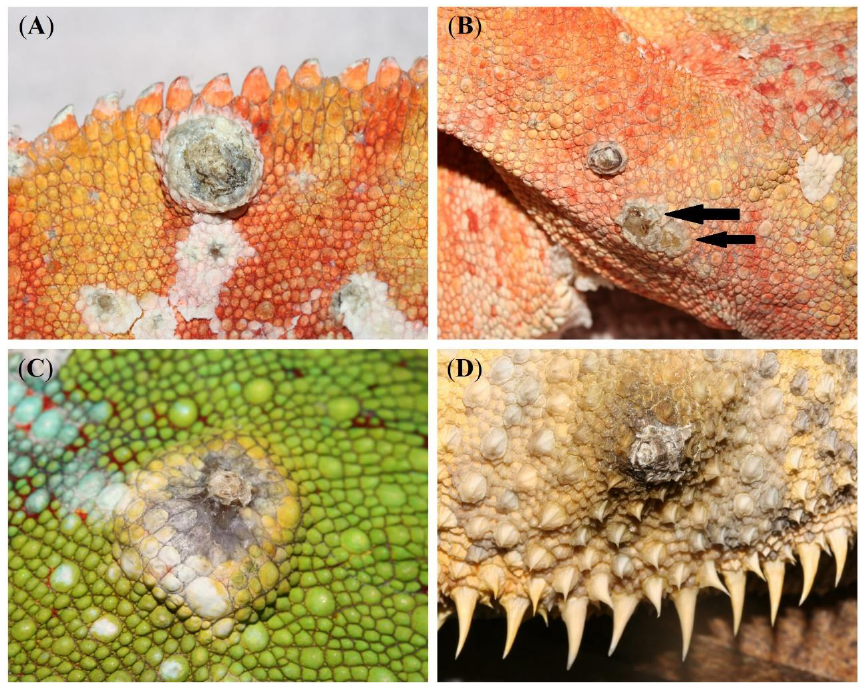
Figure 1. Nodular, crateriform dermal lesions located at the dorsolateral body wall in two panther chameleons ( Furcifer pardalis ) ( A , B , C ) and a bearded dragon ( Pogona vitticeps ) ( D ) that were histologically diagnosed as keratoacanthoma (KA). KAs presented as whitish-greyish crateriform nodules with a keratinous core. Especially in smaller lesions, the central keratin plug detached spontaneously when digital pressure was applied (arrows) ( B ).